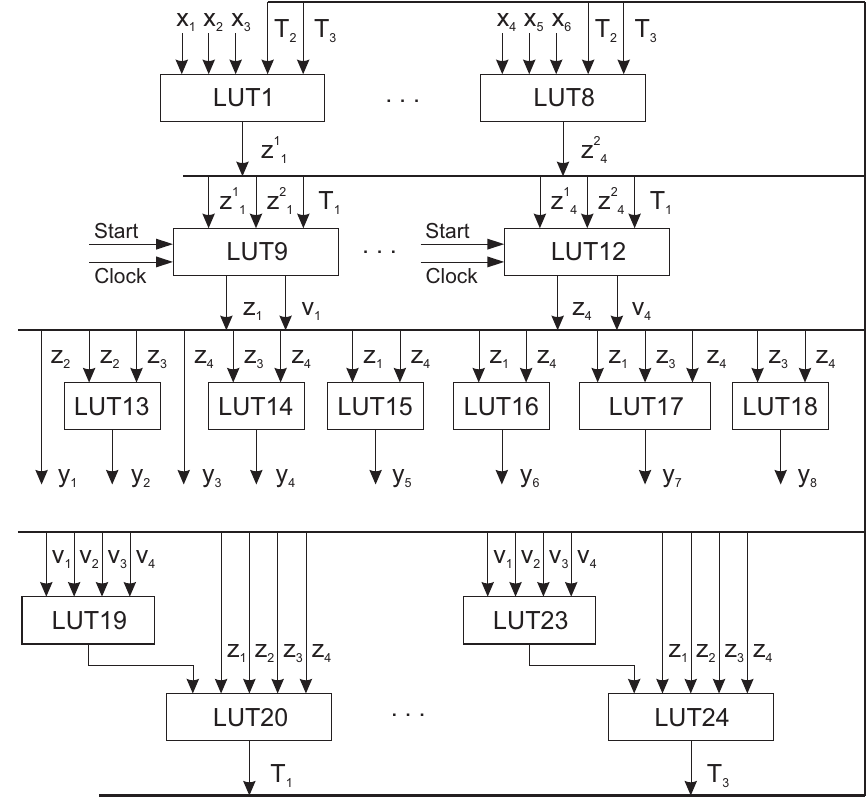
Figure 11. Logic circuit of Mealy FSM P C Z ( S 1 )